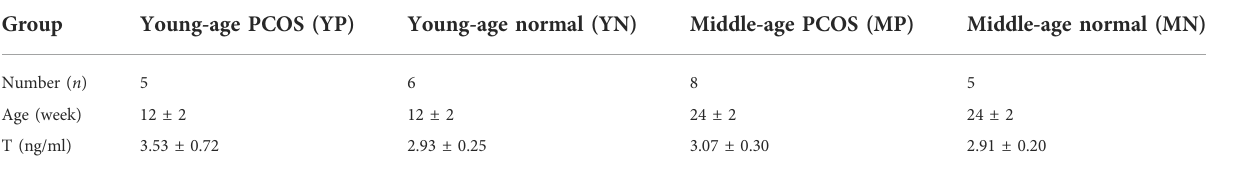
Figure 5A. Three key modules (brown, turquoise, and blue) were identi fi ed, and the grey module represented the group of metabolites that had outlying correlation with others. The association between traits and module epigenegens (MEs) were performed, and the results were shown using the heatmap (Figure 5B). The main members and their associations were shown using network diagrams (Figures 5C,D). In particular, most of the metabolites within the brown module were fatty acids, including fi ve saturated long-chain fatty acids and fi ve unsaturated long-chain fatty acids. Both the blue and turquoise modules appeared to have a high correlation with “ exosome ” , suggesting that the metabolites falling in these modules were mainly enriched in exosomes rather than expressed in cells of liver tissues.